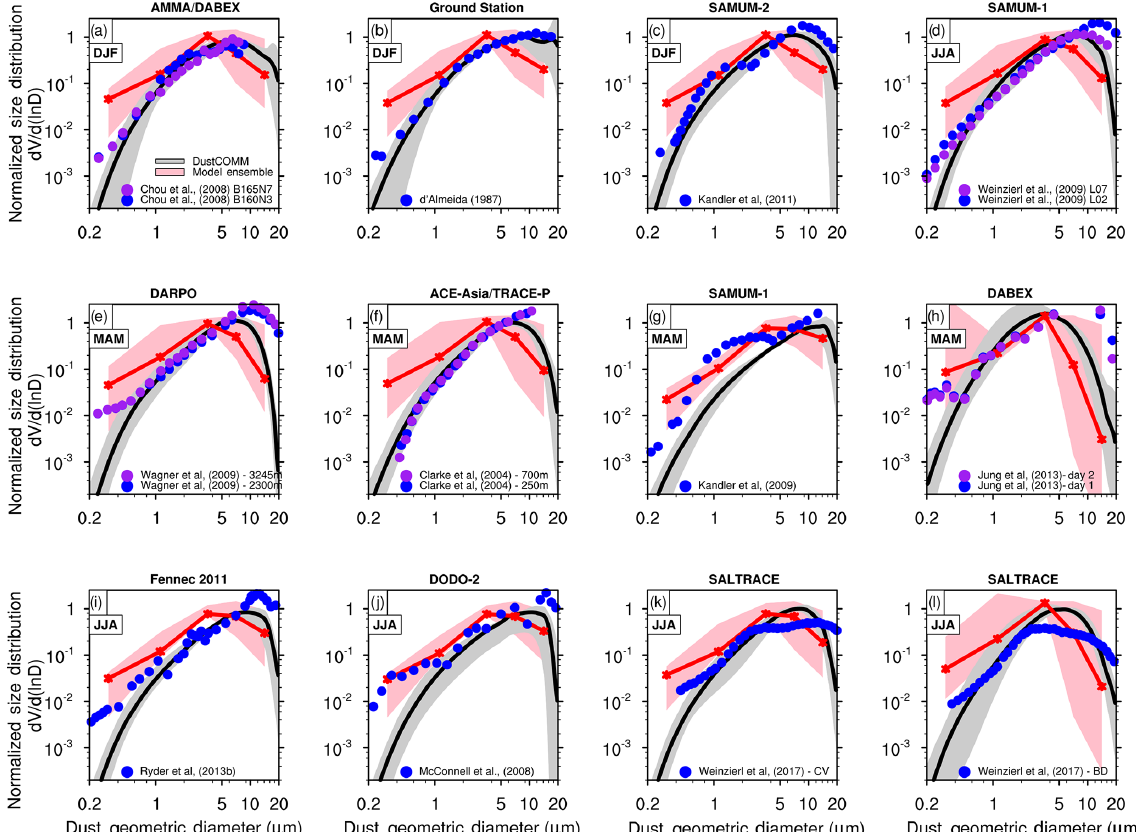
Figure 2. Comparison of normalized dust size distributions between published in situ measurements (blue and purple dots; see Table 2) and season-averaged DustCOMM (black lines) and model ensemble (red lines) estimates. The grey shading shows the 95% confidence interval for the DustCOMM dust size distributions, whereas the pink shading shows the range of the model ensemble size distributions. The size distributions are normalized between 2.5 and 10µm. The comparisons are made at the nearest model grid points to the representative location and height level of the